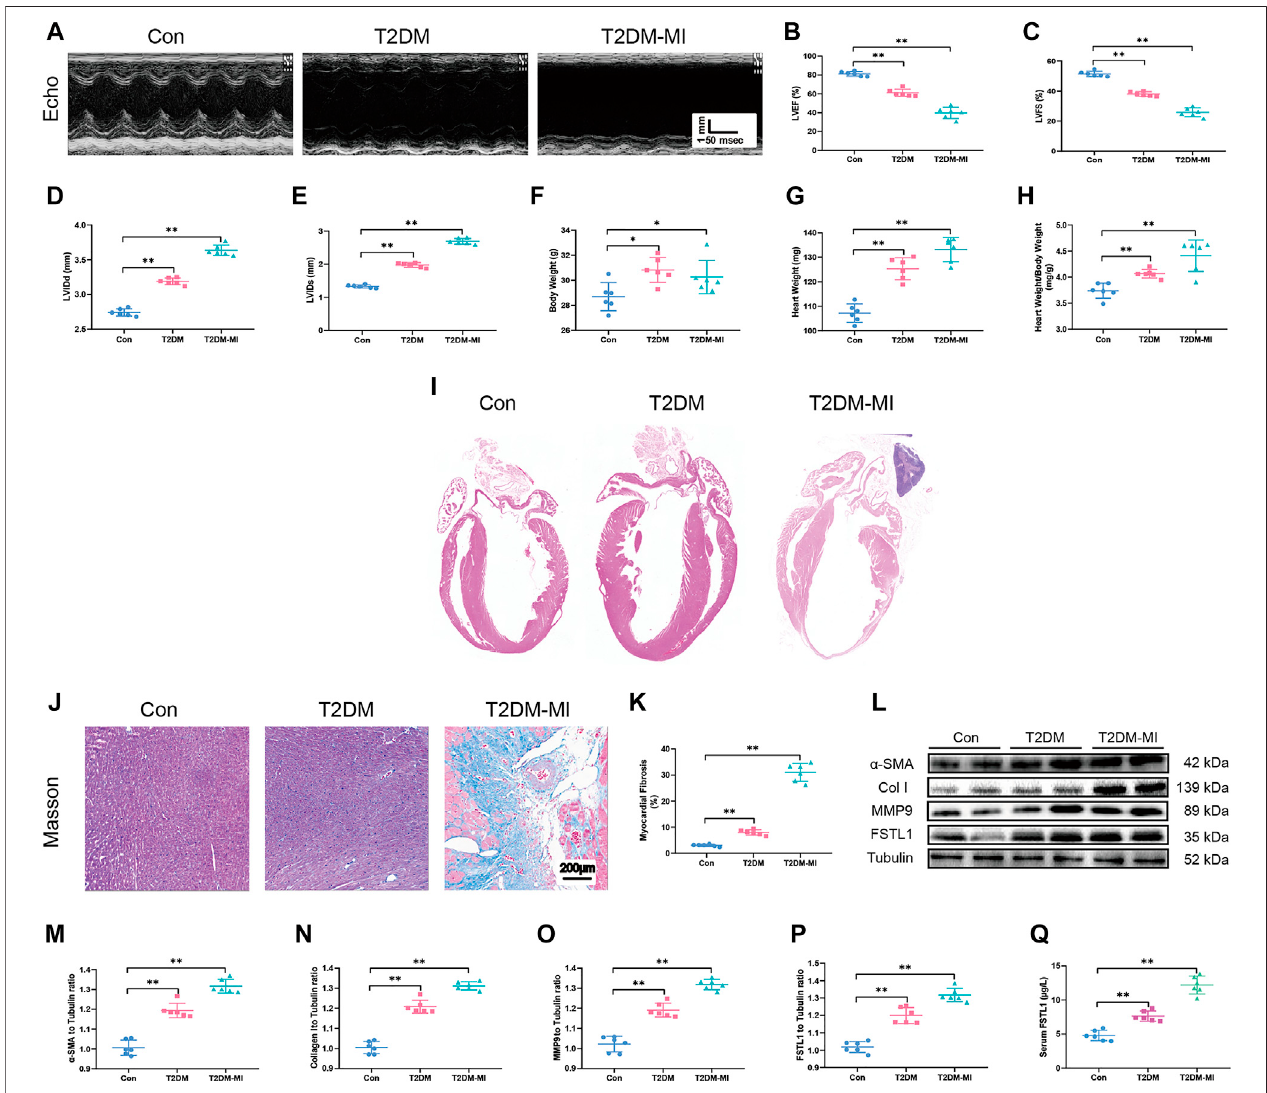
FIGURE 2 | Echocardiographic function, levels of FSTL1 and myocardial fi brosis in high fat diet-induced T2DM mice following with sham or MI injury. (A) Representative M-mode images of echocardiography challenged with MI injury in T2DM mice; (B) Left ventricular ejection fraction (LVEF); (C) Left ventricular fractional shortening (LVFS); (D) left ventricular internal diameter at end-diastole (LVIDd); (E) Left ventricular internal diameter at end-systole (LVIDs); (F) Body weight; (G) Heart weight; (H) Heart weight to body weight ratio; (I) H&E staining; (J) Cardiac interstitial fi brosis using Masson ’ s Trichrome staining; (K) Pooled data of interstitial fi brotic area of myocardial tissues; (L) Representative images of Western blot in high fat diet-induced T2DM challenged with MI injury; (M) α -SMA level; (N) Collagen I level; (O) MMP9levels; (P) FSTL1levels;and (Q) SerumLDHlevel.Con:normalcontrol;T2DM:highfatdiet-inducedT2DM;T2DM-MI,miceunderwentmyocardialinjury in T2DM. Mean ± SEM, n (cid:2) 6 per group. ** p < 0.01. scale bar (cid:2) 200 μ M.